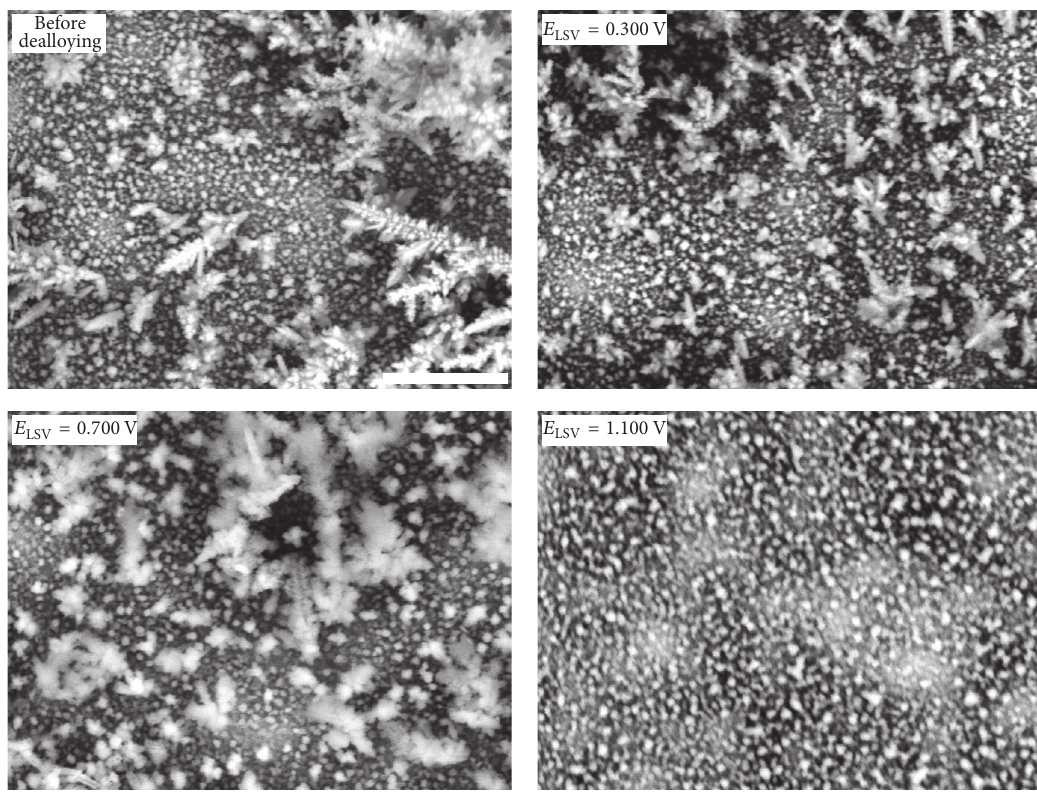
Figure 9: SEM images of samples from the high Ni percentage NiCoCu samples (Set C) before dealloying and after different dealloying steps. The scale bar is 5 𝜇 m for all the